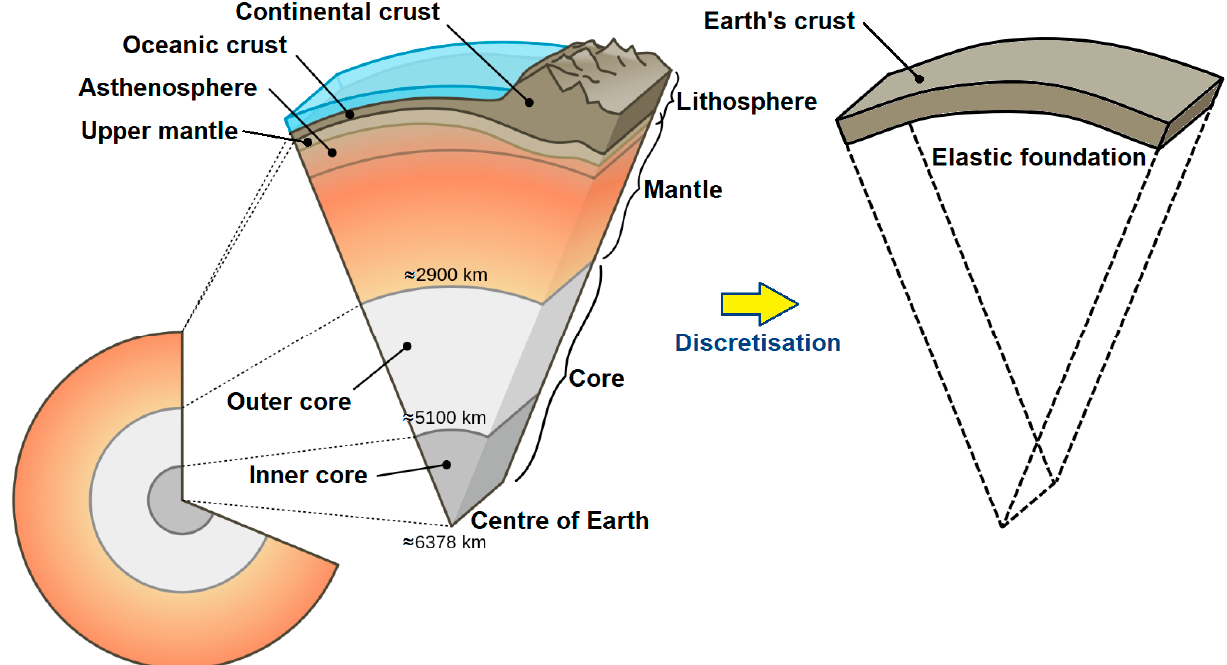
Figure 1. Structure of the Earth and the possible discretization applied (not to scale). The Earth’s crust is an anisotropic, heterogeneous upper part of the geoid and is sim- pli fi ed in the analysis as a planar, piecewise, homogeneous, isotropic model with time- varying temperature functions of illumination, i.e., thermal radiation, from the Sun. The la tt er are considered in the local isotropy sections of the model.